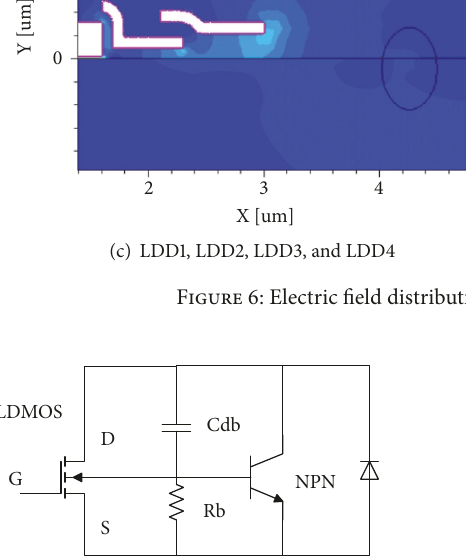
Figure 7: Electric equivalent circuit of LDMOS